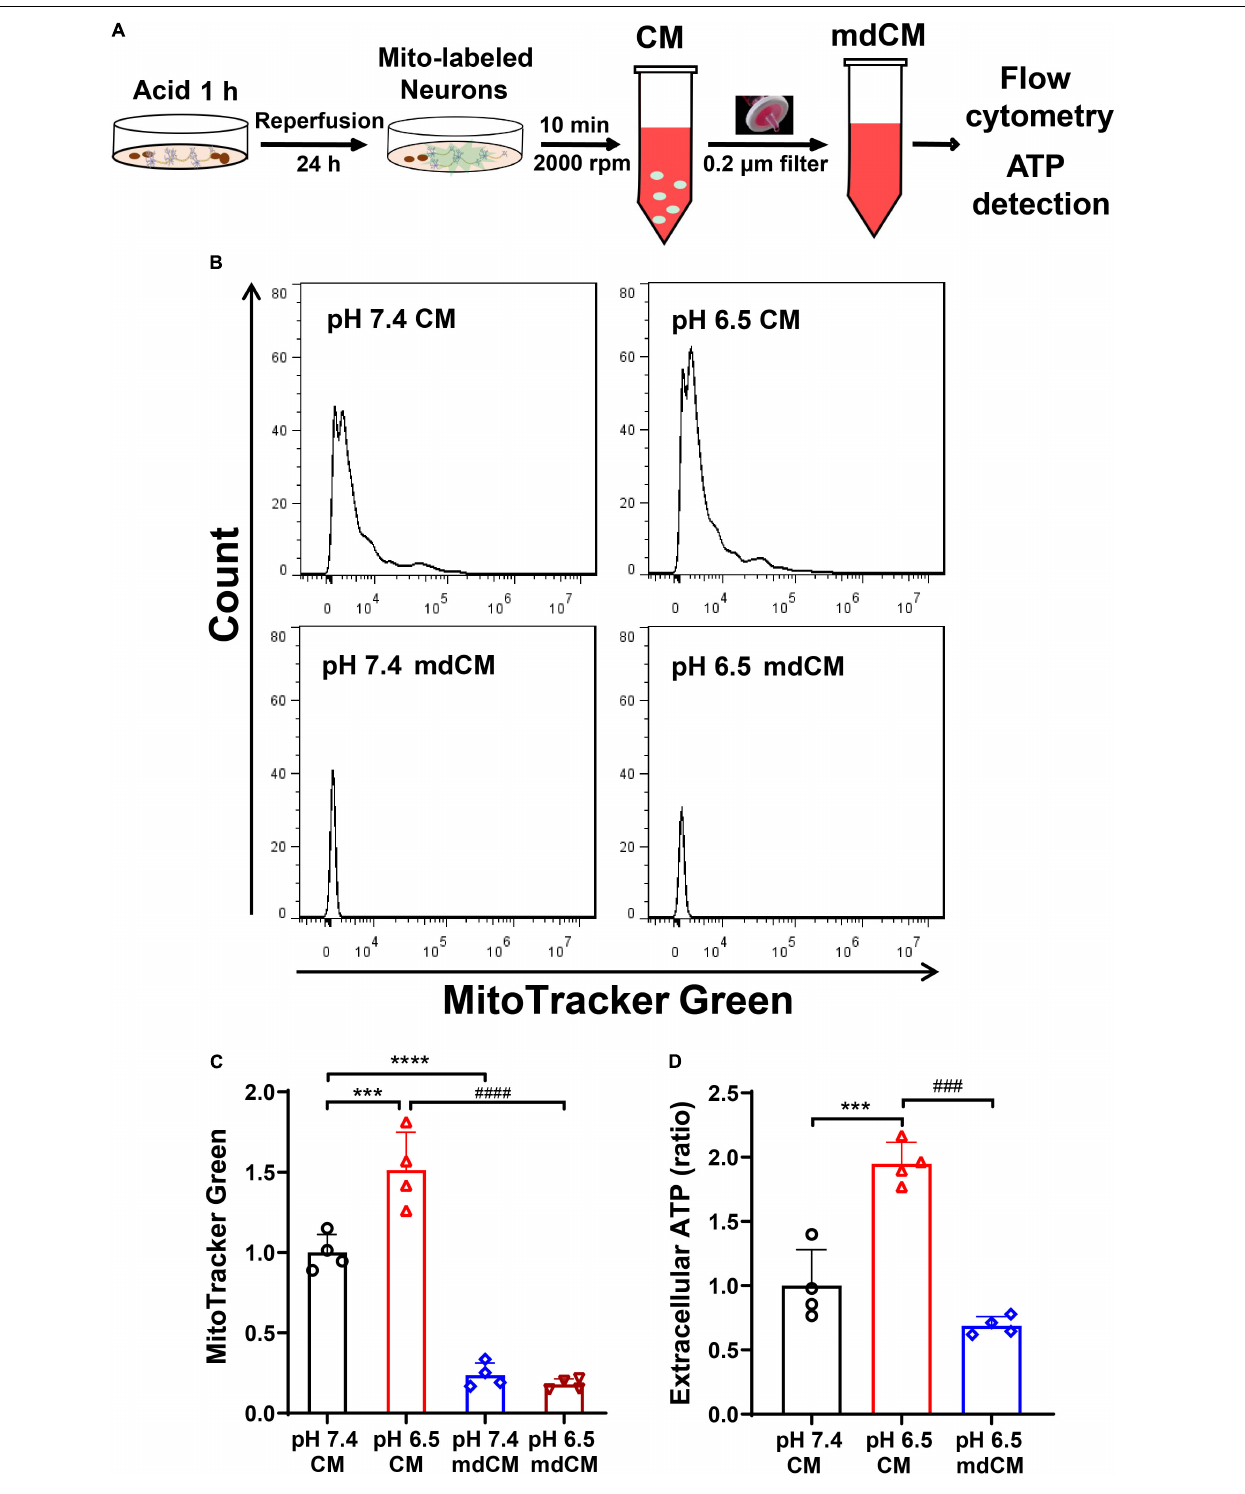
FIGURE 2 | Neurons released mitochondria under the acidosis. (A) Schematic diagram describing the experimental procedure. (B) The presence of neuronal mitochondria in culture medium (CM) and mitochondria-depleted culture medium (mdCM) in both groups was analyzed by flow cytometry. (C) The neuronal mitochondria labeled with MitoTracker Green increased in CM treated with a pH 6.5 solution when compared with the pH 7.4 group, but decreased significantly in mdCM in both pH 7.4 and 6.5 groups. (D) The extracellular ATP increased significantly in CM after pH 6.5 treatment, but the ATP concentration decreased dramatically in mdCM after pH 6.5 treatment. n = 4. *** p < 0.001, **** p < 0.0001 vs. pH 7.4 CM; ### p < 0.001, #### p < 0.0001 vs. pH 6.5